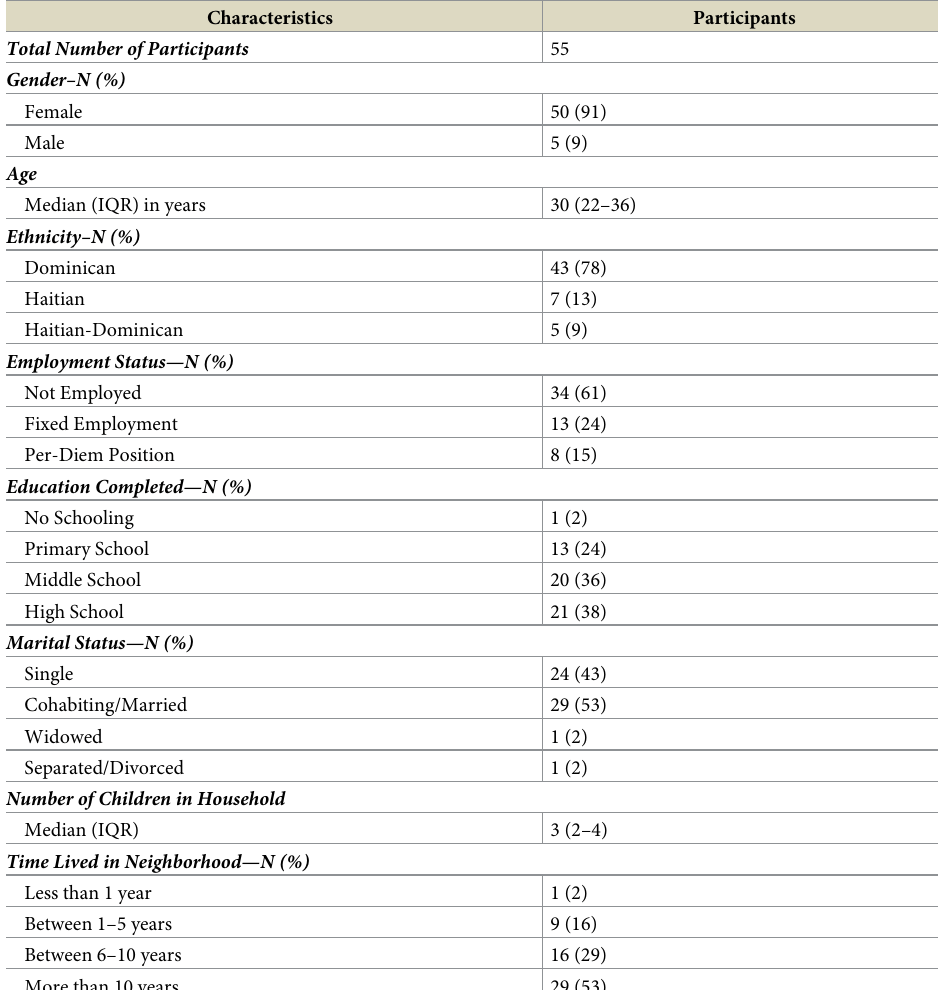
Table 1. Participant